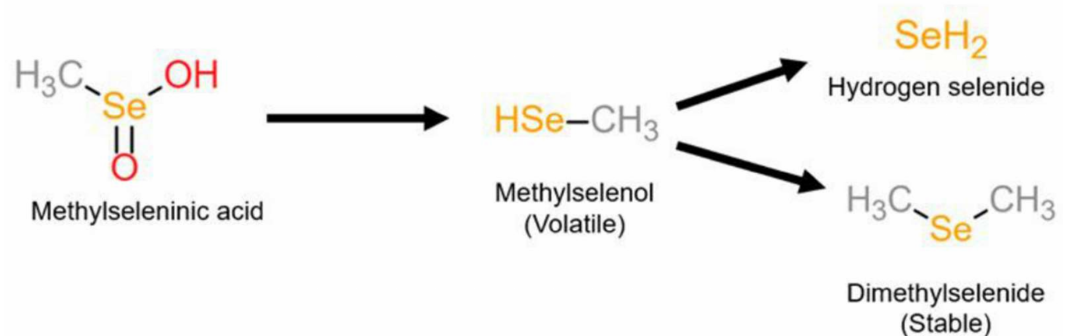
Figure 4. Metabolism of methylselenic acid (MSA). MSA is reduced to the volatile metabolite methylselenol, which is further reduced to hydrogen selenide or methylated to the stable dimethyl